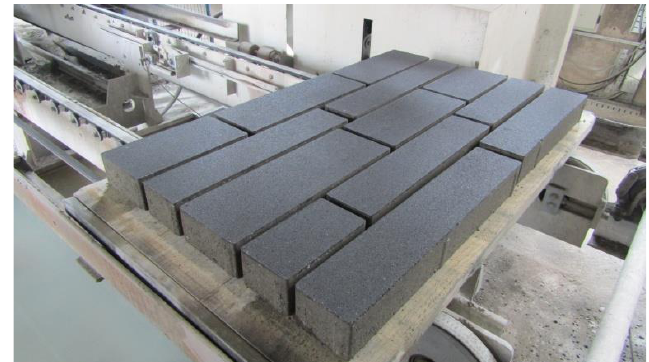
Figure 6. Appearance of concrete blocks and flags.